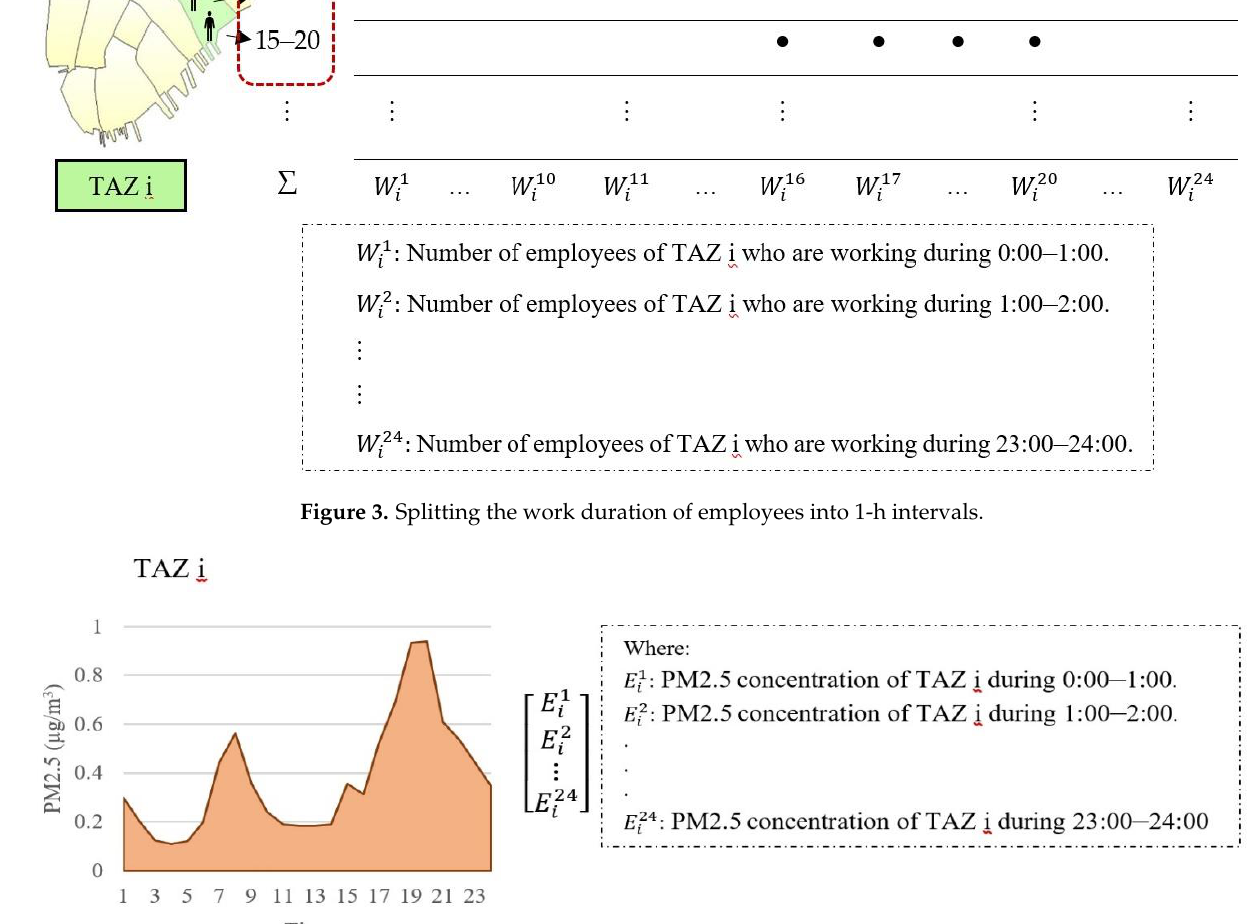
Figure 4. Average hourly PM2.5 concentration over TAZs .